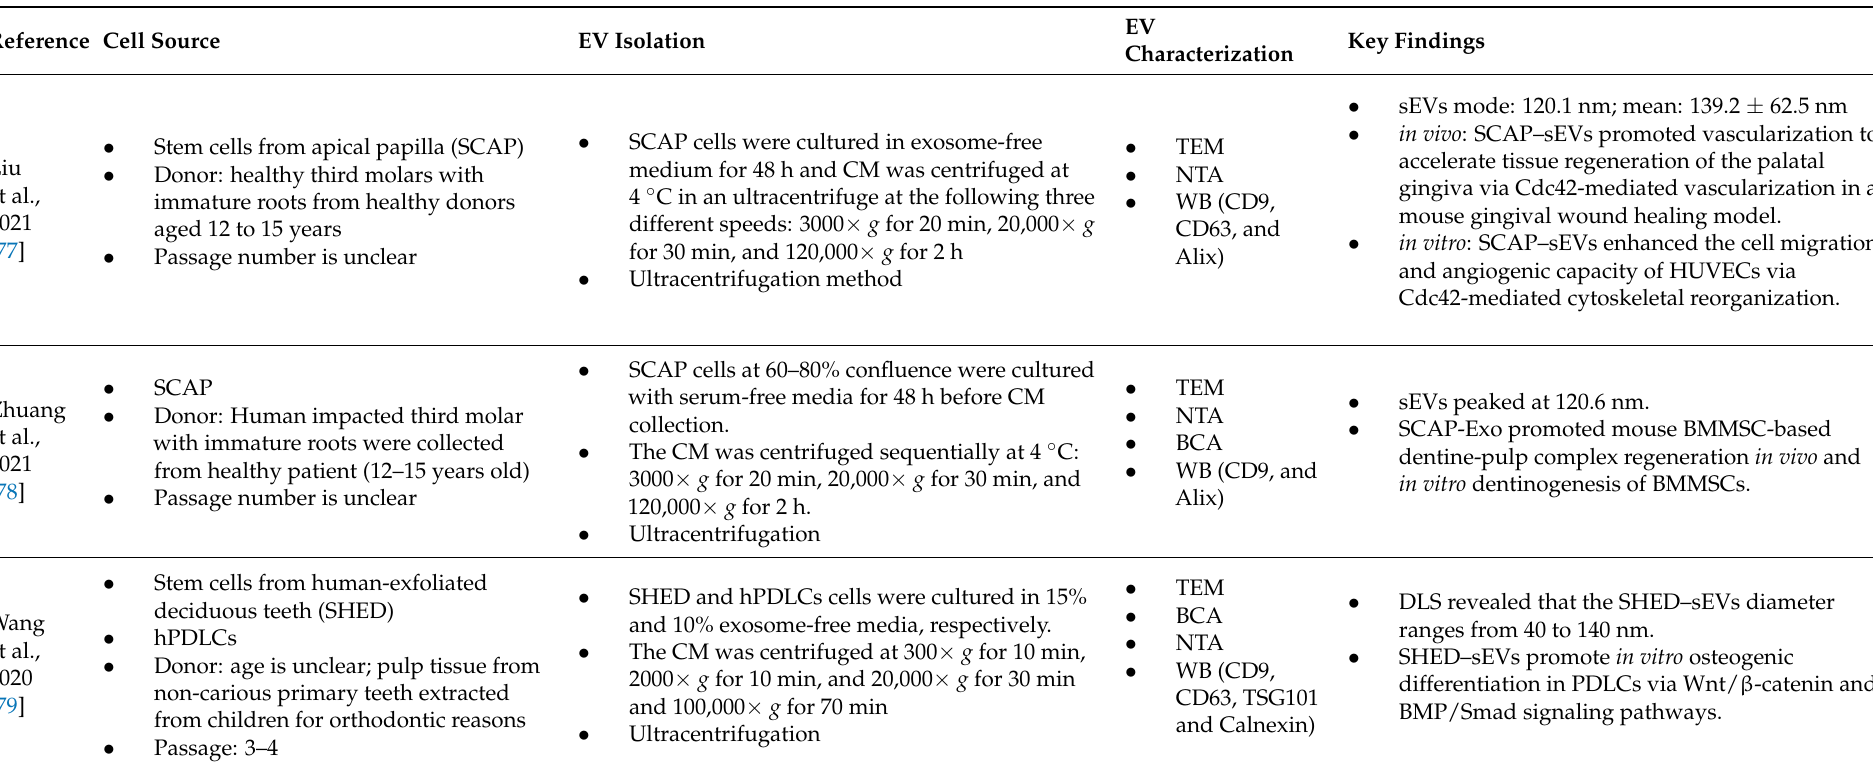
Table 5. The isolation, characterization, and function of sEVs from SHED, SCAP and DFCs.